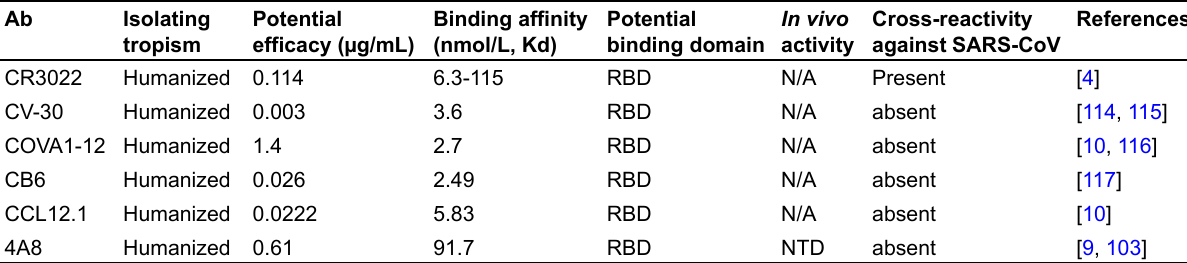
List of Abs undergoing to treat SARS-CoV-2, revealing potential isolating source tropism, binding specificity, affinity, and cross- reactivity against SARS-CoV